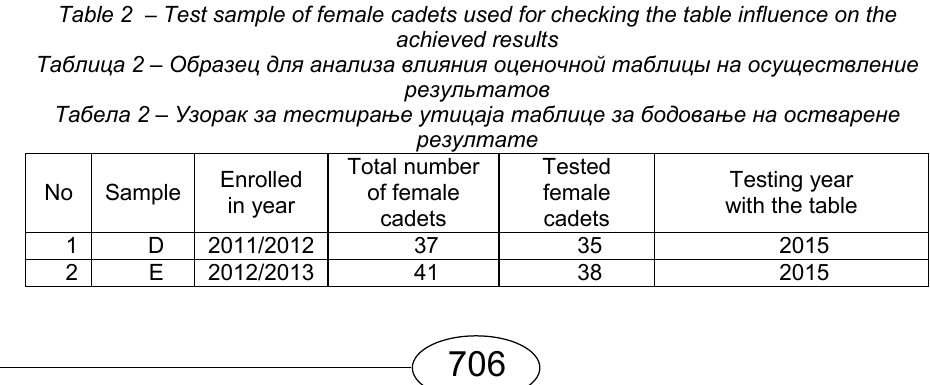
Table 2 – Test sample of female cadets used for checking the table influence on